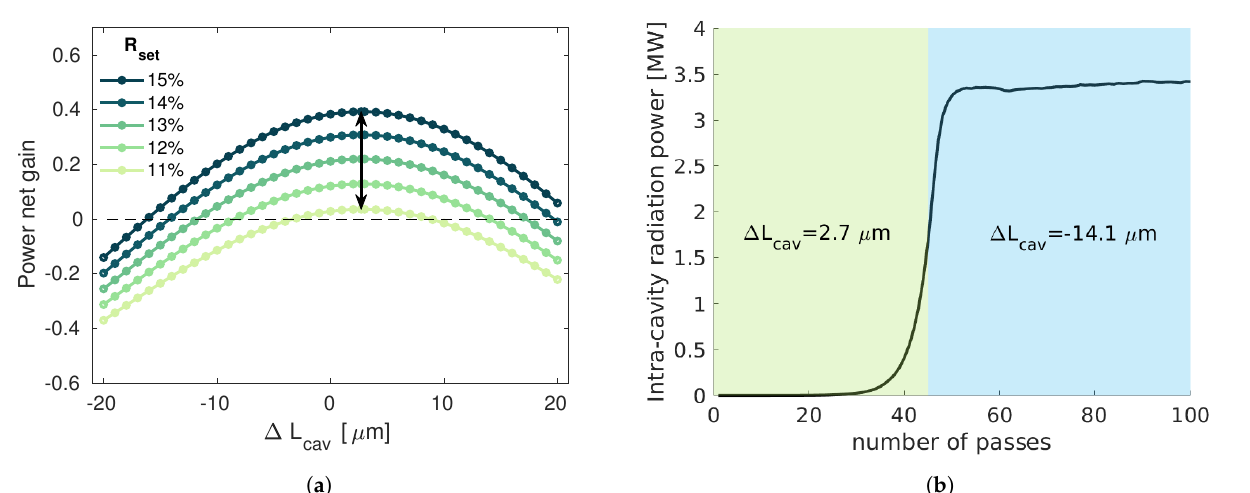
Figure 8. ( a ) Detuning curves for a 300fs flat-top electron beam. The optimum detuning length is at ∆ λ = 2.7 µ m, for all set reflectivities, as shown with the vertical arrow. The zero net gain point shown with the horizontal dashed line, shows the detuning that needs to be applied to reach equilibrium for each total reflectivity R set . Keeping the reflectivity constant and changing the cavity length can transition the system from positive to zero net gain. We remind the readers that the power net gain has no units as it is the difference between the peak power at the beginning of pass n + 1 and at pass n, divided by the peak power at pass n. ( b ) With an oscillator starting from the random fluctuation of the electron beam distribution, a transition between amplification of the power and maintenance of the peak power is achieved by detuning the cavity length from ∆ L cav = 2.7 µ m to ∆ L cav = 14.1 µ m. For all passes the reflectivity is R set = −